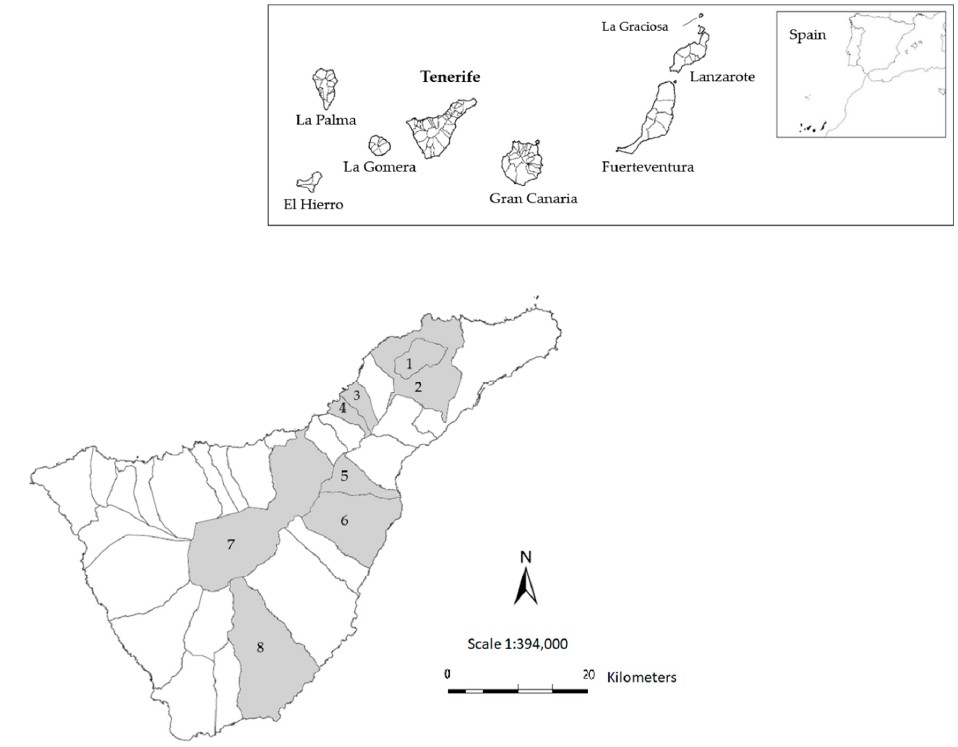
Figure 1. Map of the sampled locations on Tenerife island. The municipalities where fecal samples were collected are shown in gray—1: Tegueste, 2: San Cristóbal de La Laguna, 3: El Sauzal, 4: La Matanza de Acentejo, 5: Arafo, 6: Güímar, 7: La Orotava, 8: Granadilla de Abona. The original